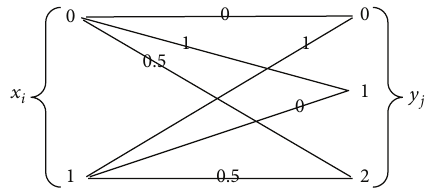
Figure 1: The distortion measurement